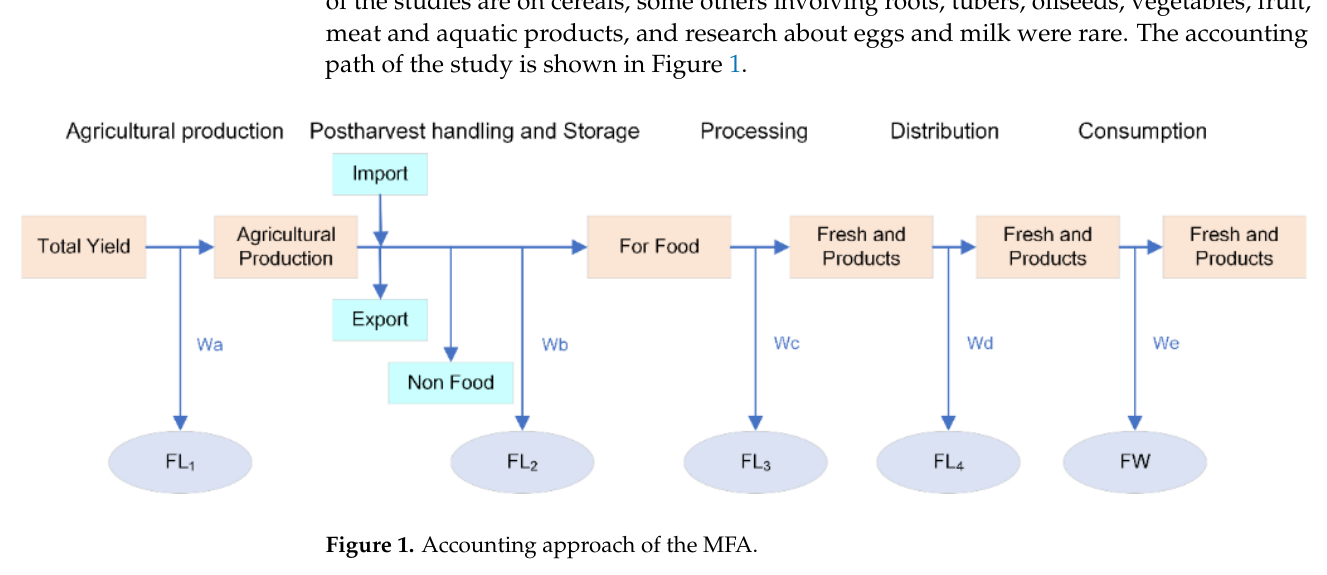
Accounting approach of the